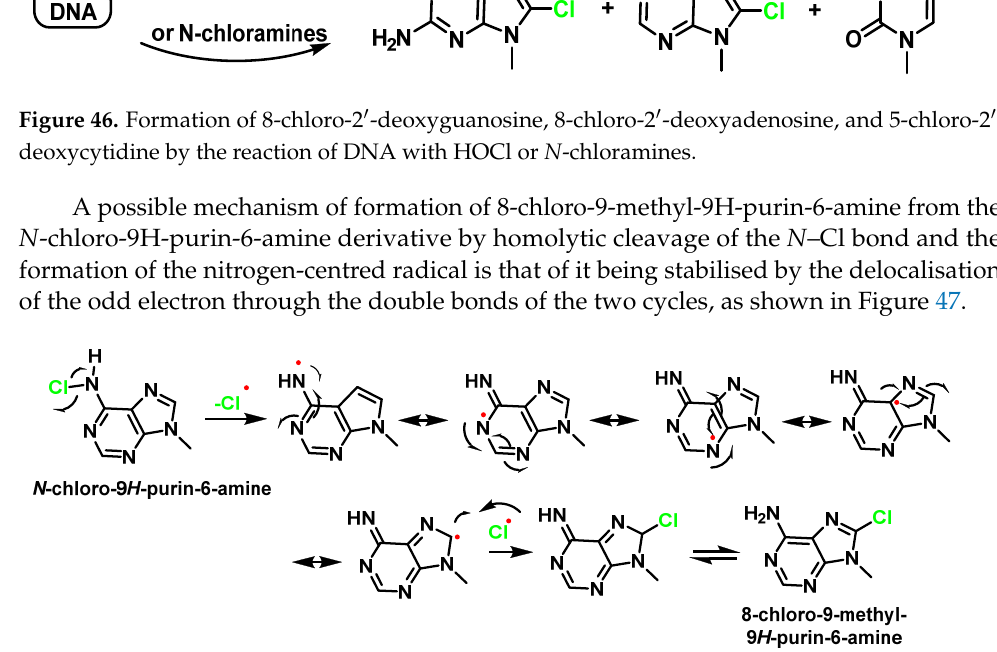
Figure 45. Formation of chloroamines and the breaking of the hydrogen bond.